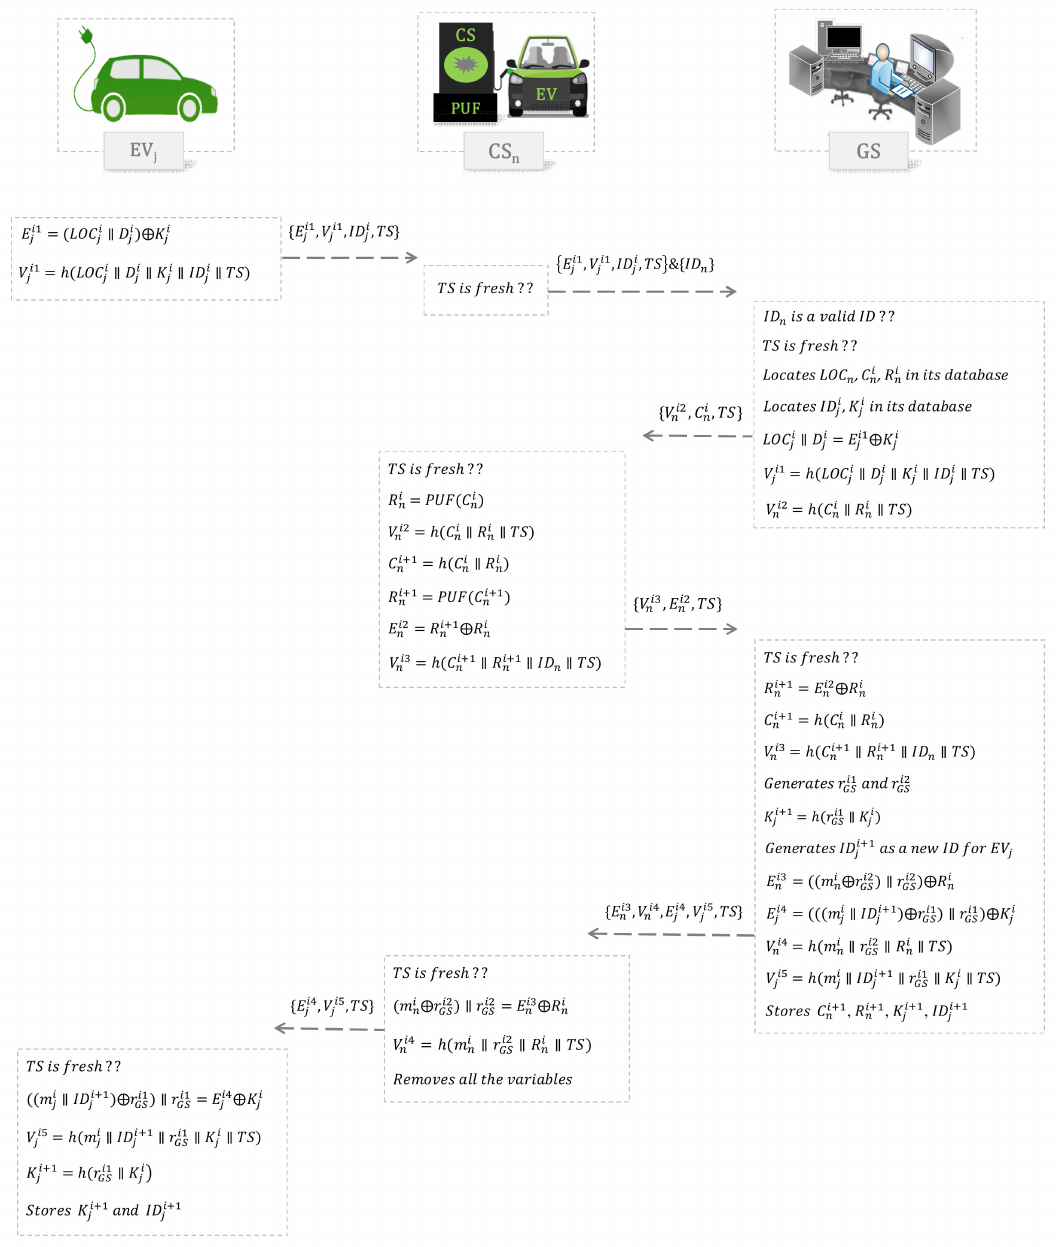
Figure 3. The proposed